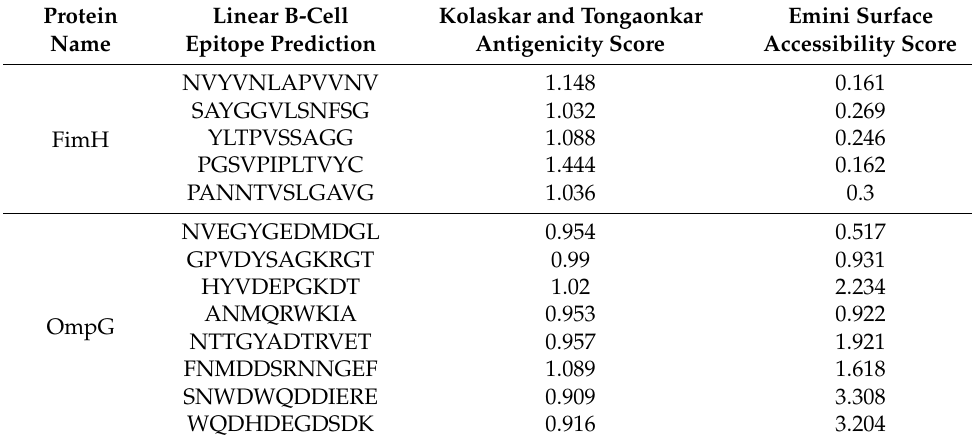
Table 2. Predicted linear B-cell epitopes selected based on their antigenicity and surface accessibil- ity